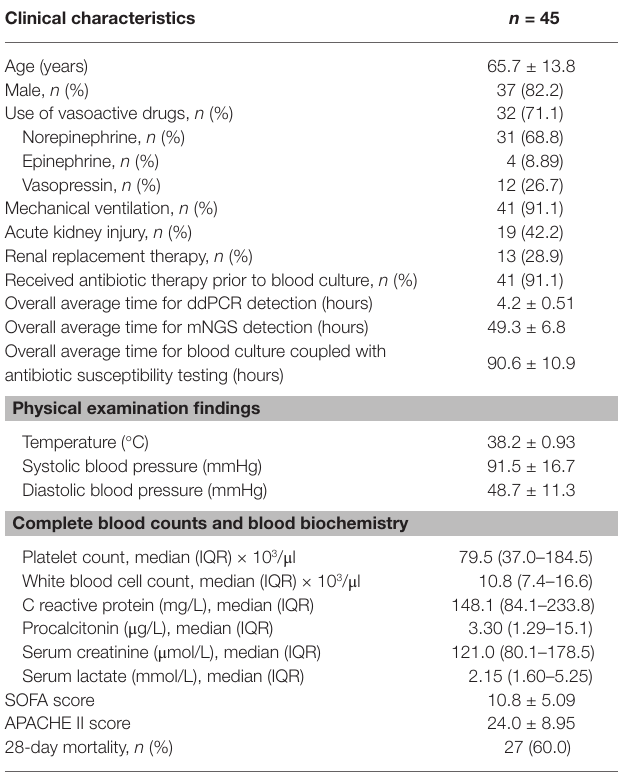
TABLE 1 | Characteristics of the